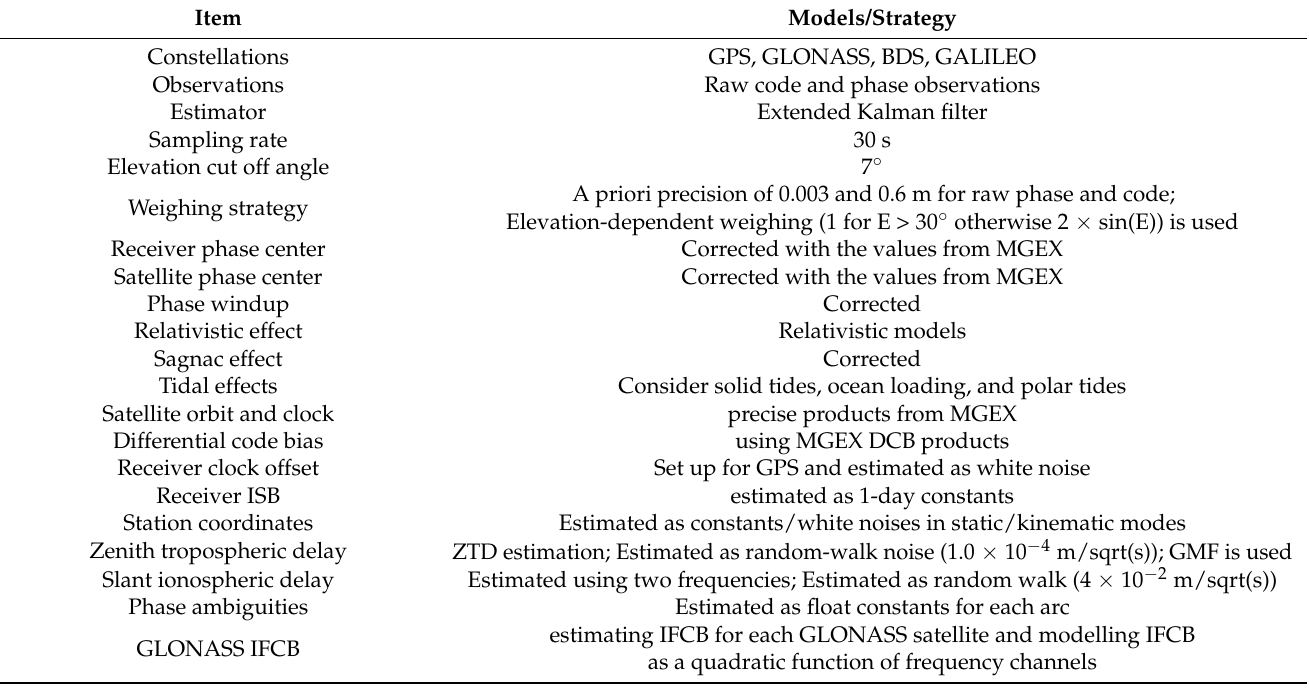
Figure 2. The flow chart of PPP processing strategy. Table 1. Detailed processing models and strategies applied for combined